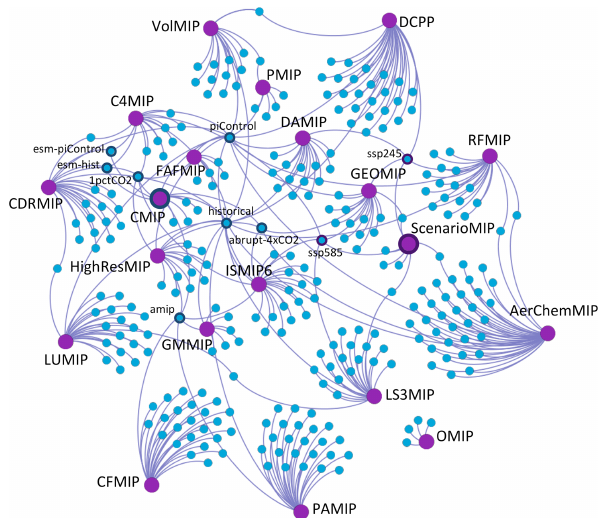
Figure 5. CMIP6 MIPs and experiments. Individual MIPs are rep- resented by large purple dots. Lines connect each MIP to the exper- iments that are related to it, which are shown as smaller blue dots. Some widely used experiments are labelled, such as the piControl, historical, amip, ssp245, and ssp585, which are used by numerous MIPs within